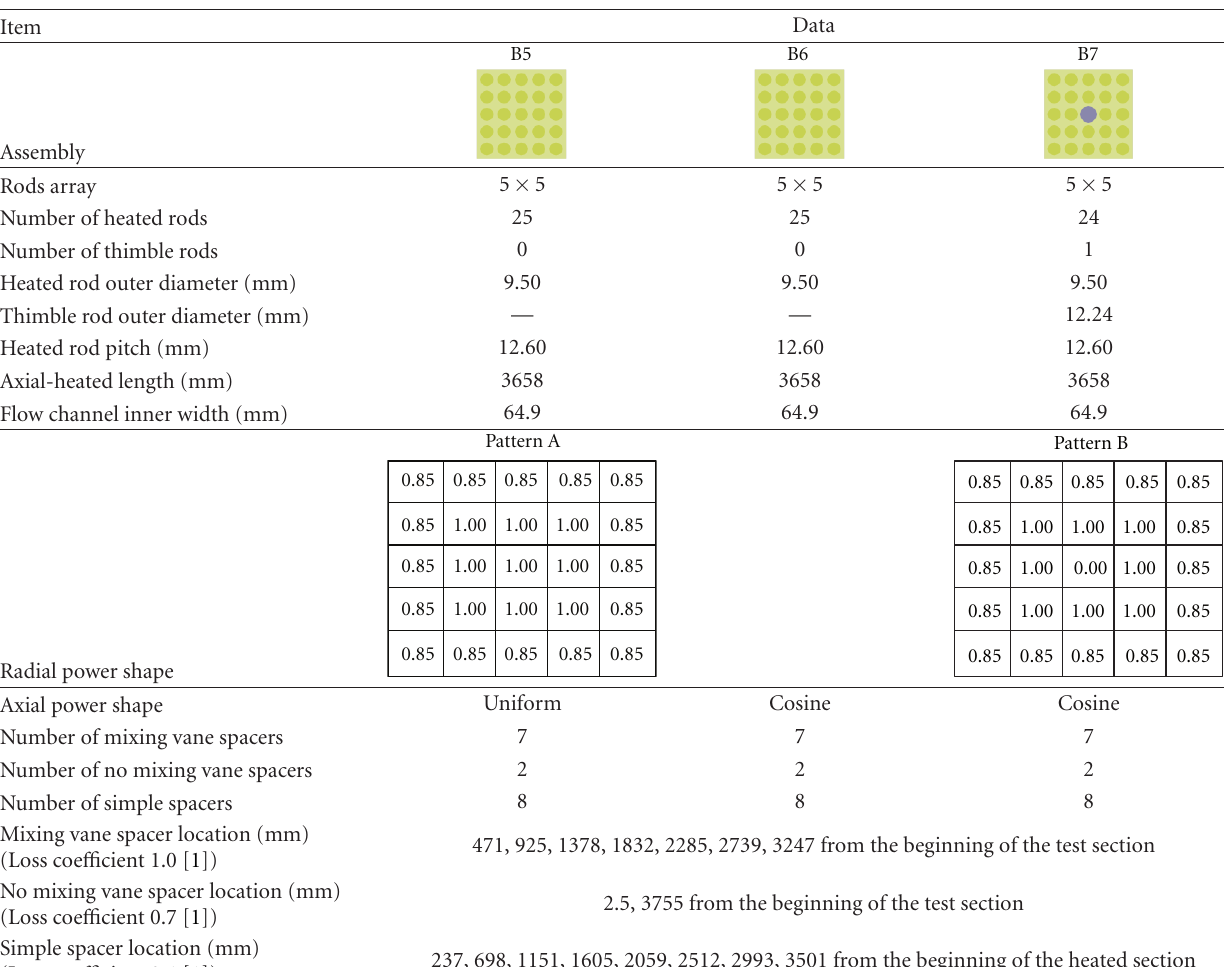
Table 6: Geometry and power shape of rod bundle test assembly.